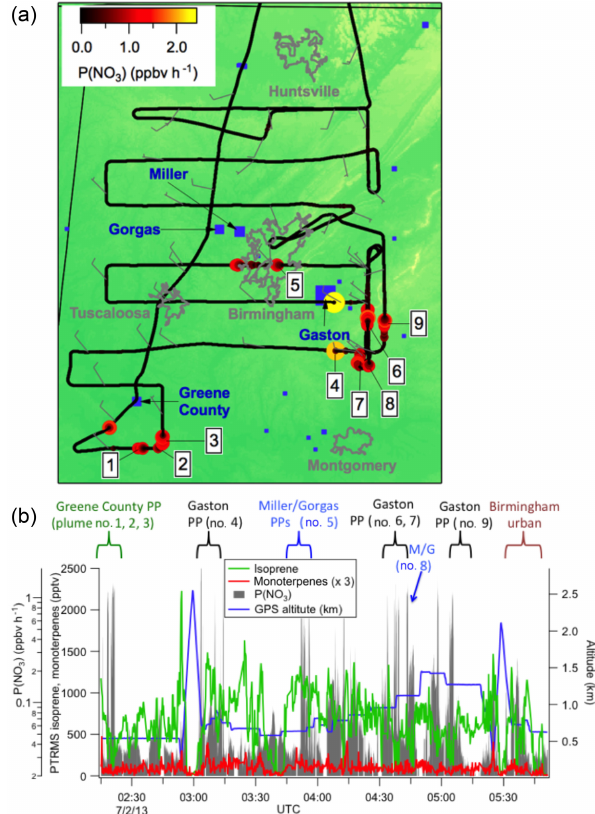
Figure 1. (a) Map of northern Alabama, showing the location of the flight track of the 2 July 2013 night flight used in the present anal- ysis, with plume numbers labeled and wind direction shown. Al- though the wind direction changed throughout the night, these mea- surements enable us to attribute each plume to a power plant source (see labels in Fig. 1b and Table 2). Color scale shows P (NO 3 ) based on aircraft-measured [NO 2 ] and [O 3 ], while power plants discussed in the text are indicated in blue squares with marker size scaled to annual NO x emissions for 2013 (scale not shown). Isoprene emis- sions are widespread in the region (Edwards et al., 2017). Panel (b) shows time series data from the same flight, with plume ori- gins and numbers labeled, showing aircraft-measured isoprene and monoterpene concentrations, altitude, and P (NO 3 ) determined ac- cording to Eq. (2) (log scale), showing that the isoprene was uni- formly distributed (mixing ratios often in excess of 1ppbv), while the more reactive monoterpenes were present at mixing ratios be- low 100ppt except at the lowest few hundred meters above ground in the vertical profiles (not used in the present analysis). Figure 1b also shows that sharp peaks in nitrate radical production rate oc- cur both at the lowest points of these vertical profiles, when the aircraft approached the surface, but also frequently during periods of level flight in the residual layer, which correspond to the power plant plume transects analyzed in this